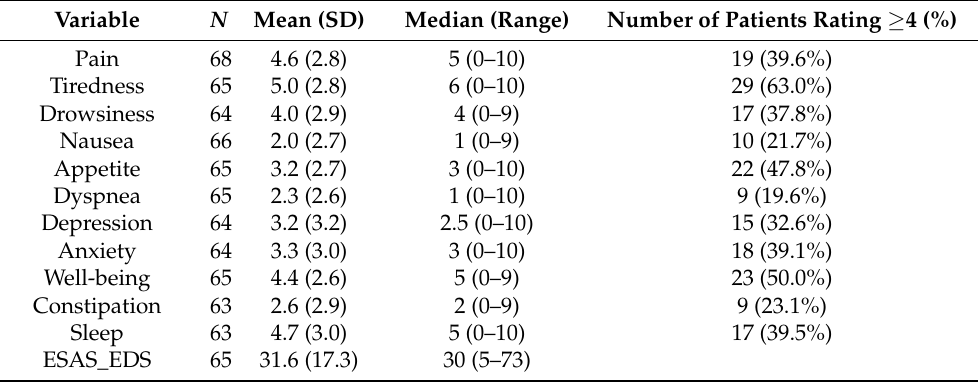
Table 2. Edmonton Symptom Assessment System scale (ESAS) scores at initial IAPCPC consultation ( n =